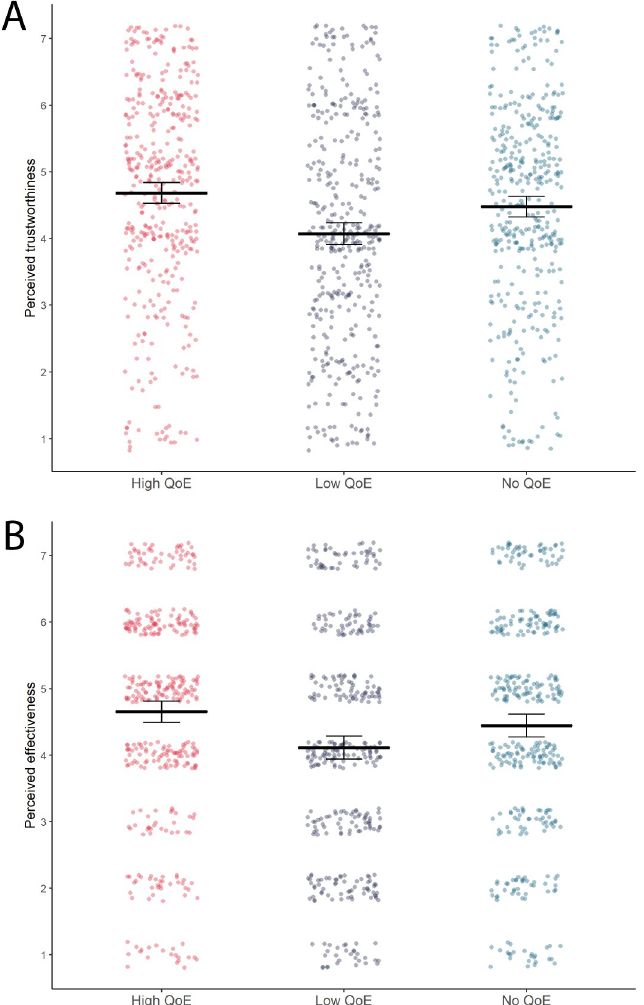
Fig 4. The effects of giving a cue as to the quality of evidence (QoE) behind an effectiveness estimate on people’s perceptions of the trustworthiness of the information (A) and the perceived effectiveness of the intervention (B). All dependent variables were measured on 7 point Likert scales ranging from 1-low to 7-high (please see Methods section for exact wording details for all measures). The two plots show mean effects and associated 95% confidence intervals (black horizontal lines and error bars), as well as underlying observed data distributions (coloured dotted points; red/left column = observations for high QoE groups, blue/middle column = observations for low QoE groups, green/right column = observations for no QoE groups). Data for both plots is depicted collapsed across formatting conditions (with/without icon arrays).